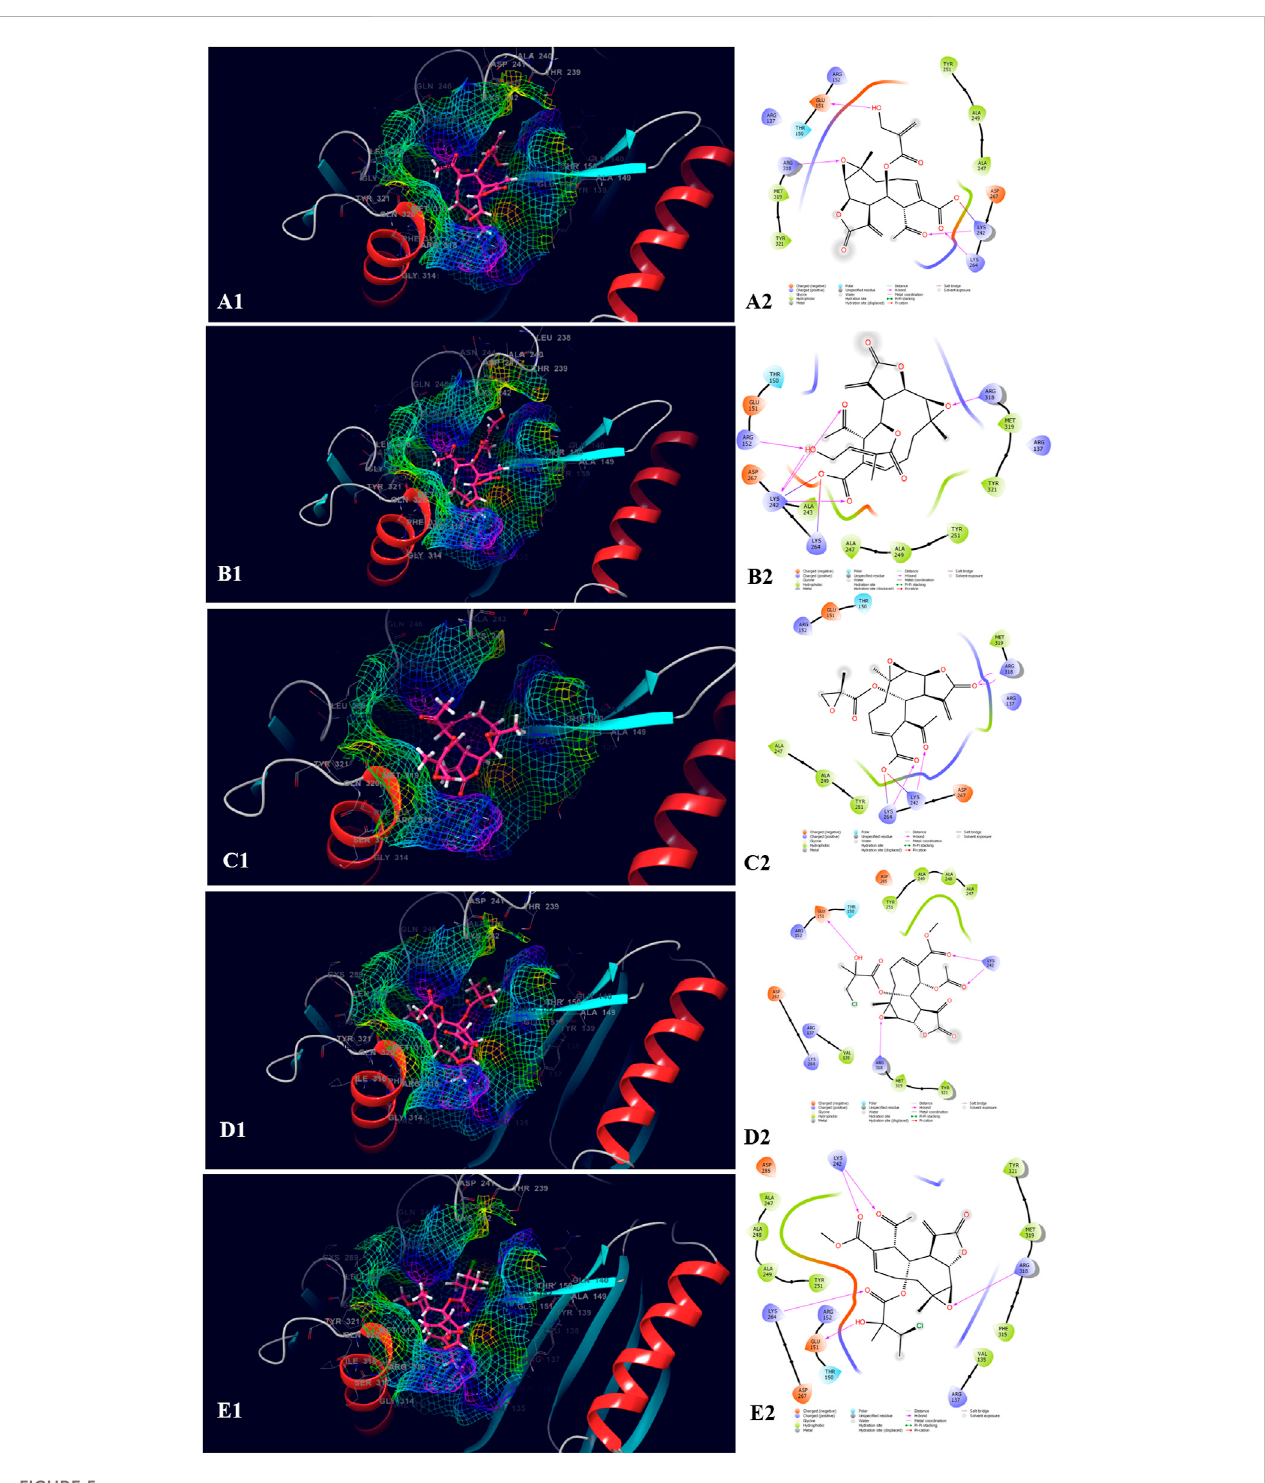
FIGURE 5 Molecular docking interactions of metabolites in the binding pocket of PDB ID: 1J72. [3D and 2D representation of 8-Desacylenhydrin-4- hydroxymethacrylate (A1,A2) , 8-Desacylenhydrin-4-hydroxytiglate (B1,B2) , 8-Desacylenhydrin-23-epoxyisobutyrate (C1,C2) , 8-Deepoxyangeloyl-8-2- hydroxy-3-chloro-isobutyroyl-enhydrin (D1,D2) , and 8-Deepoxyangeloyl-8-chloro-2-hydroxy2-methylbutyroylenhydrin (E1,E2) in the binding pocket of PDB ID: 1J72.].